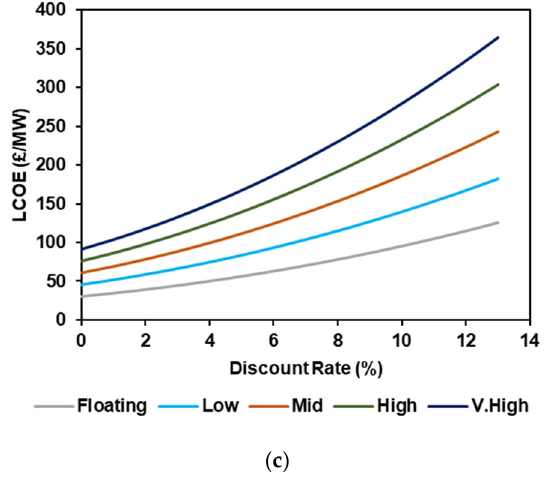
Figure 6. 25 Year analysis for ( a ) BEIS LCOE; ( b ) Fixed LCOE, and ( c ) Floating LCOE.